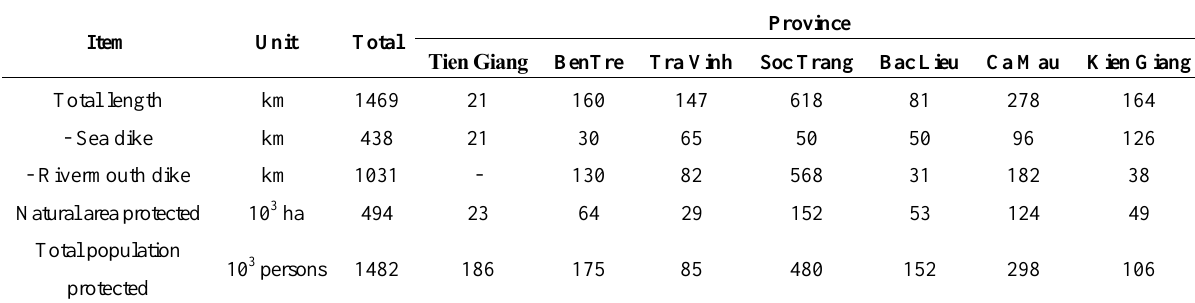
Table 1. Projected sea dike and rivermouth dike systems in the Mekong Delta. Source: Hoi